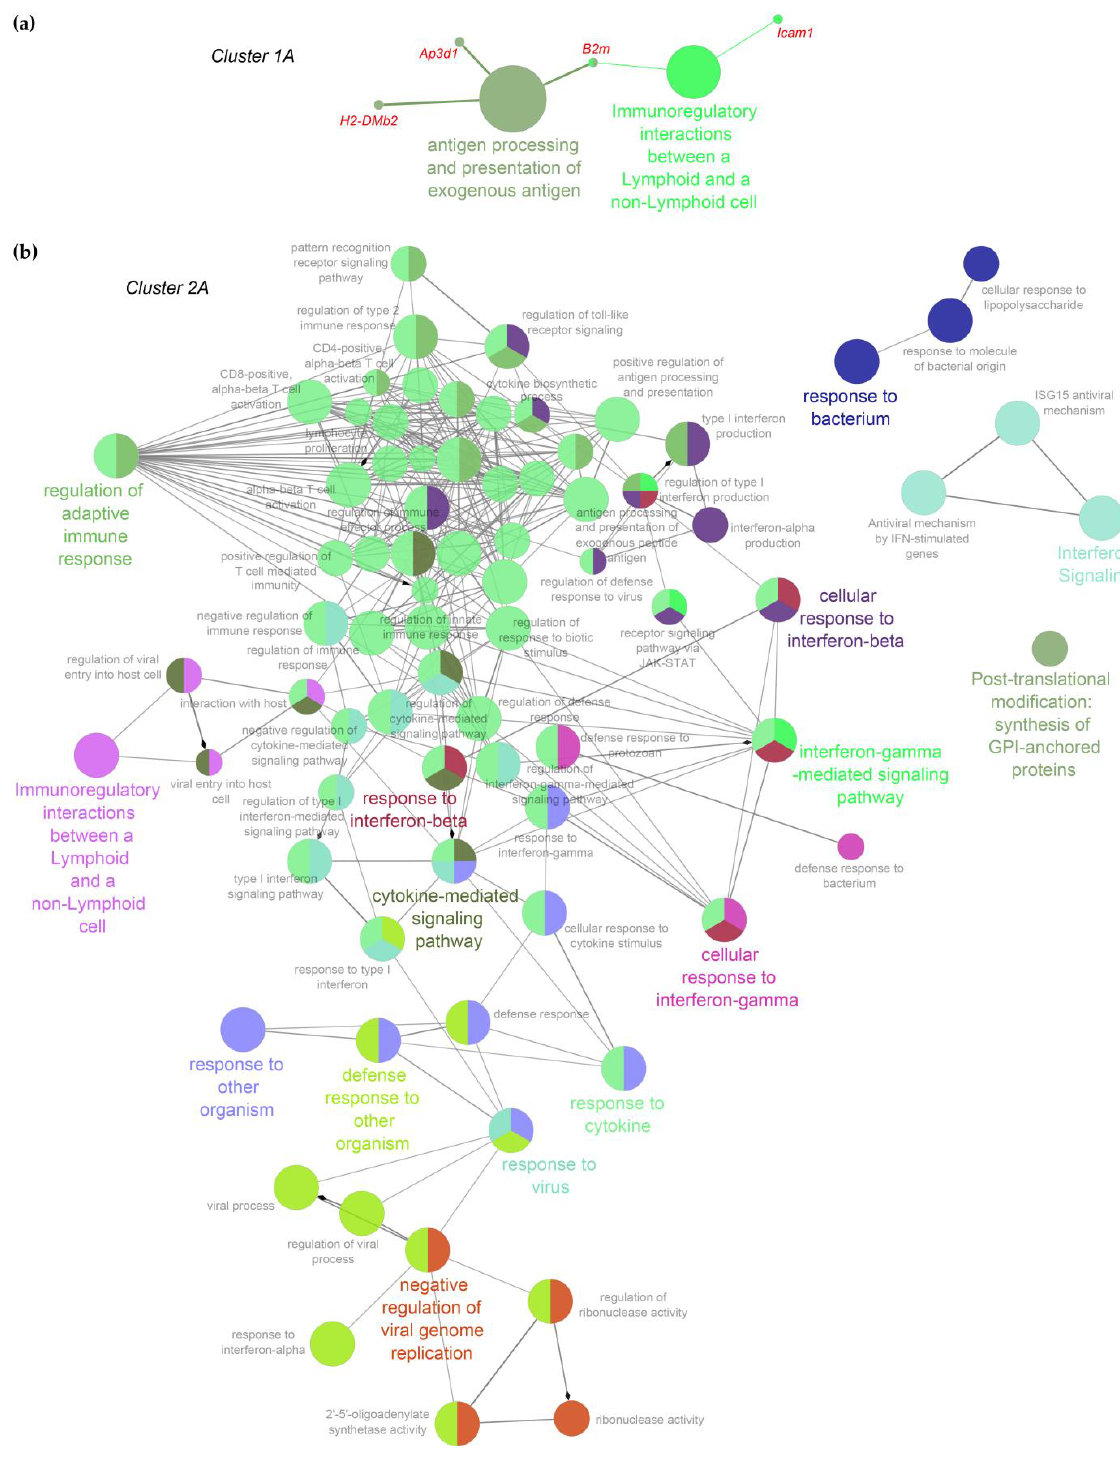
Figure 5. Enrichment networks in Young animals for clusters 1A ( a ) and 2A ( b ). The networks show the most significant gene ontology (GO)-biological processes (BP)/pathways (adjusted p -Value < 0.05) that are enriched in the transcript clusters identified by hierarchical clustering. Colors refer to groups of gene sets with related biological functions. Node size relates to gene-set significance.